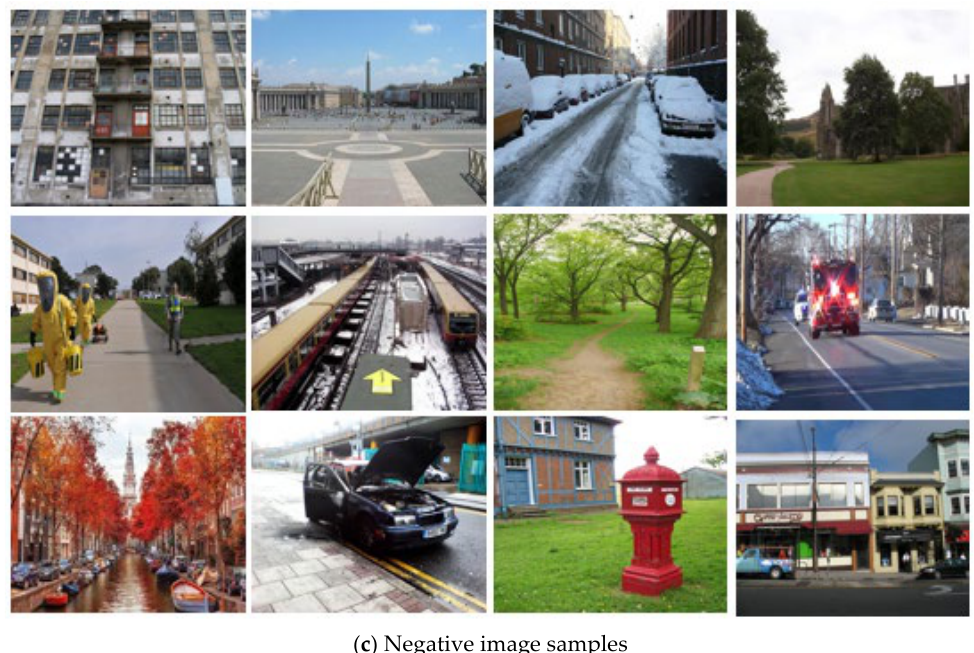
Figure 4. Example images from three classes from datasets for training capsule network.